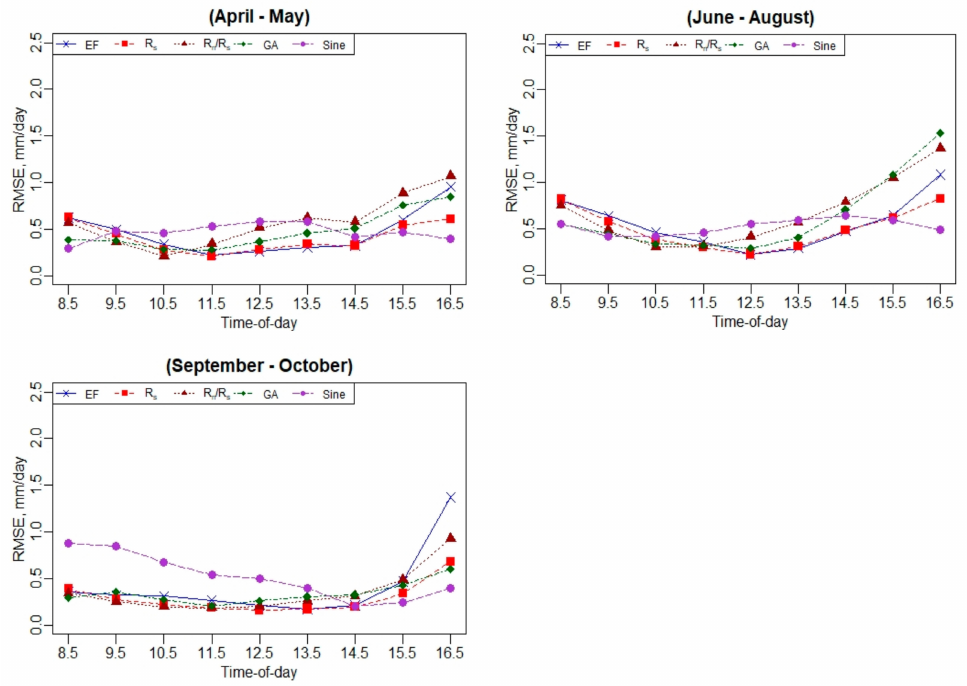
Figure A25. Daily RMSE performance using hourly EC ET